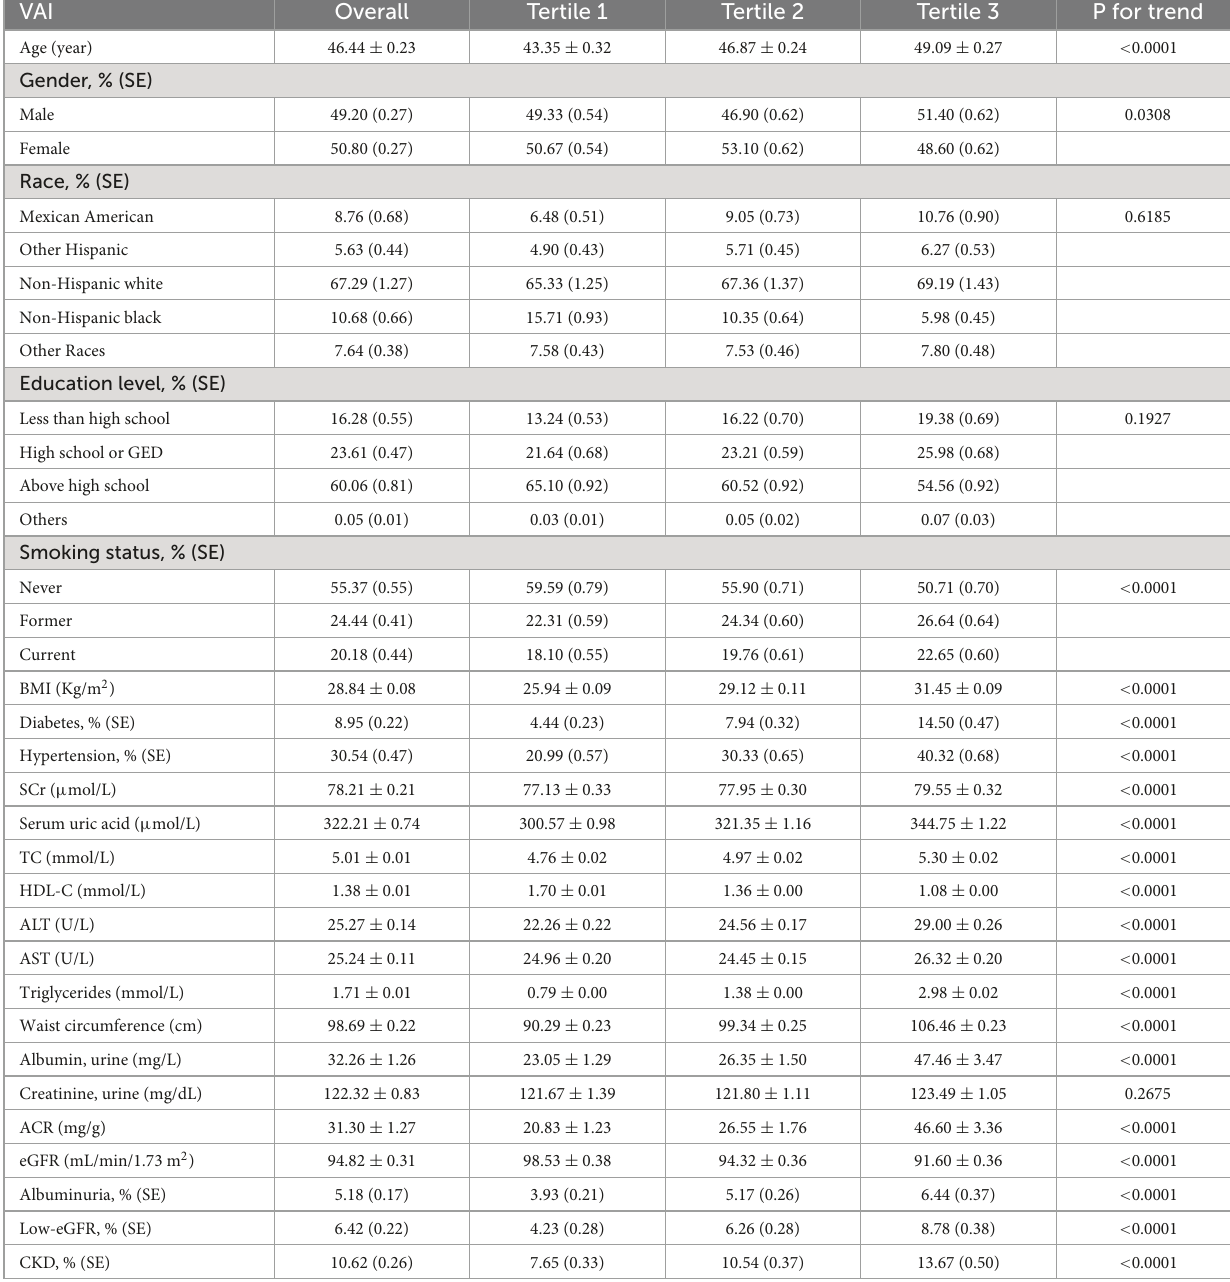
TABLE 1 Baseline characteristics according to visceral adiposity index